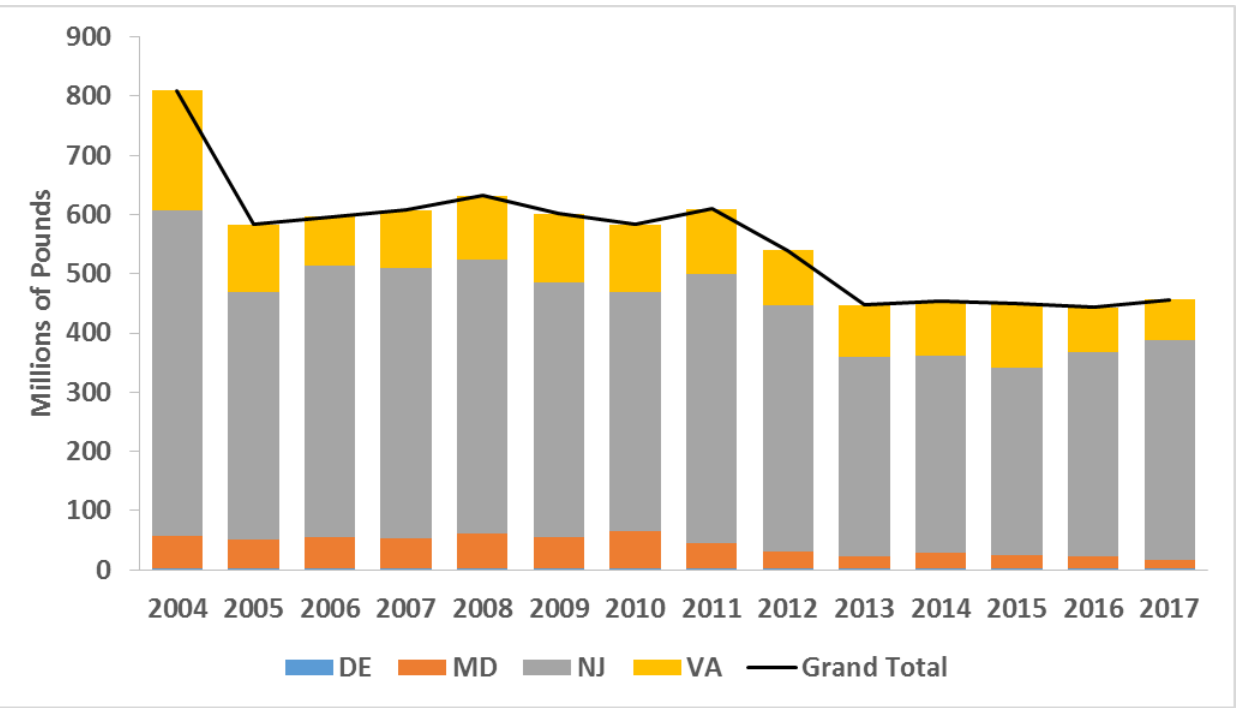
Figure 15. All species landings by state for gillnets, trawls, dredge, and “not coded” for the Delaware Bay region for 2004-2017 (source: ACCSP).